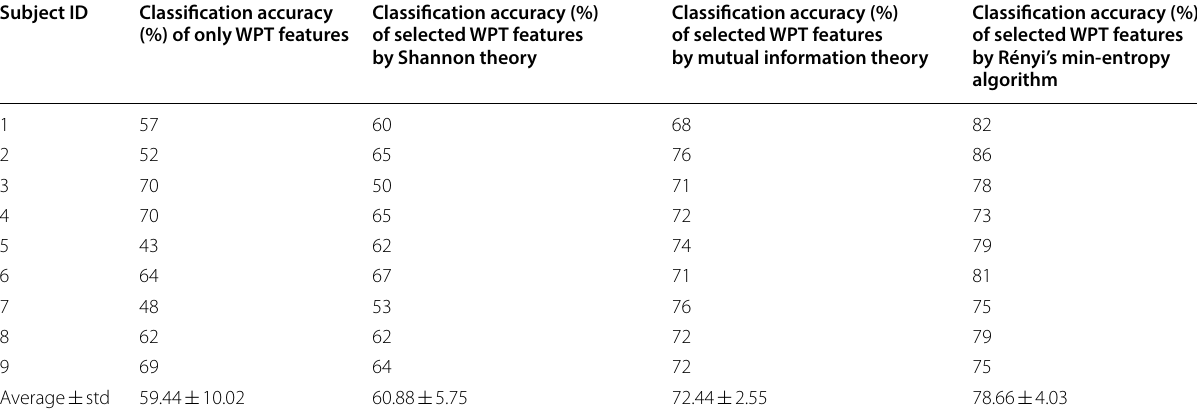
Table 1 The classification accuracy of the proposed algorithm compared to the